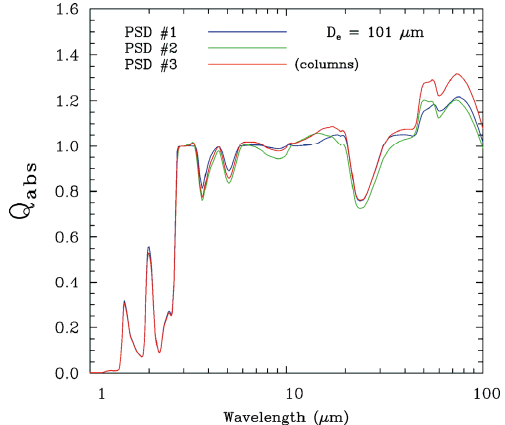
Figure 12. Wavelength dependence of Q abs for the 3 PSD described in Fig. 11, using the same Fig. 12. Wavelength dependence of Q abs for the 3 PSD described in color convention. All PSD have the same D e and IWC. MADA ice optics were used to include Fig. 11, using the same color convention. All PSD have the same D e the near infrared wavelengths. and IWC. MADA ice optics were used to include the near infrared wavelengths.